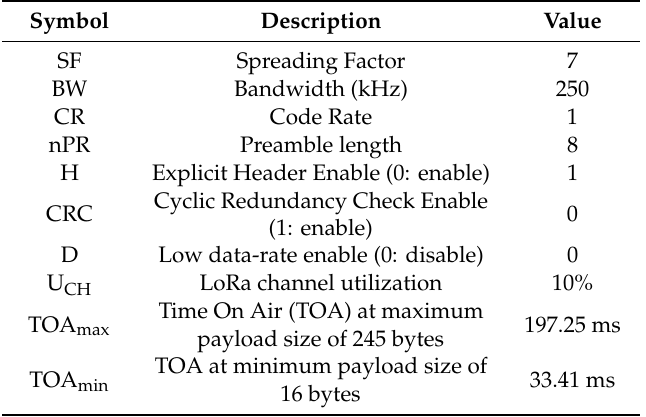
Table 4. LoRa parameters with their default and calculated